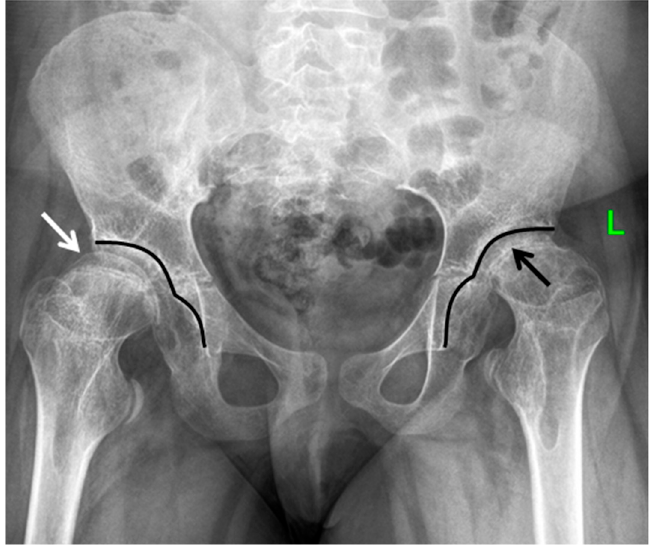
Figure 6. End-stage osteoarthritis of the hip joints of the 15-year-old patient with MED type 4. Anteroposterior radiograph of the hips: abnormal shape and structure of the epiphysis of the femoral head on the right side—half-moon shape (white arrow), secondary reduced size of the epiphysis and narrowing of the joint space on the left side (black arrow), secondary deformity of the acetabulum—doubled “seagull-like” contour (black lines).